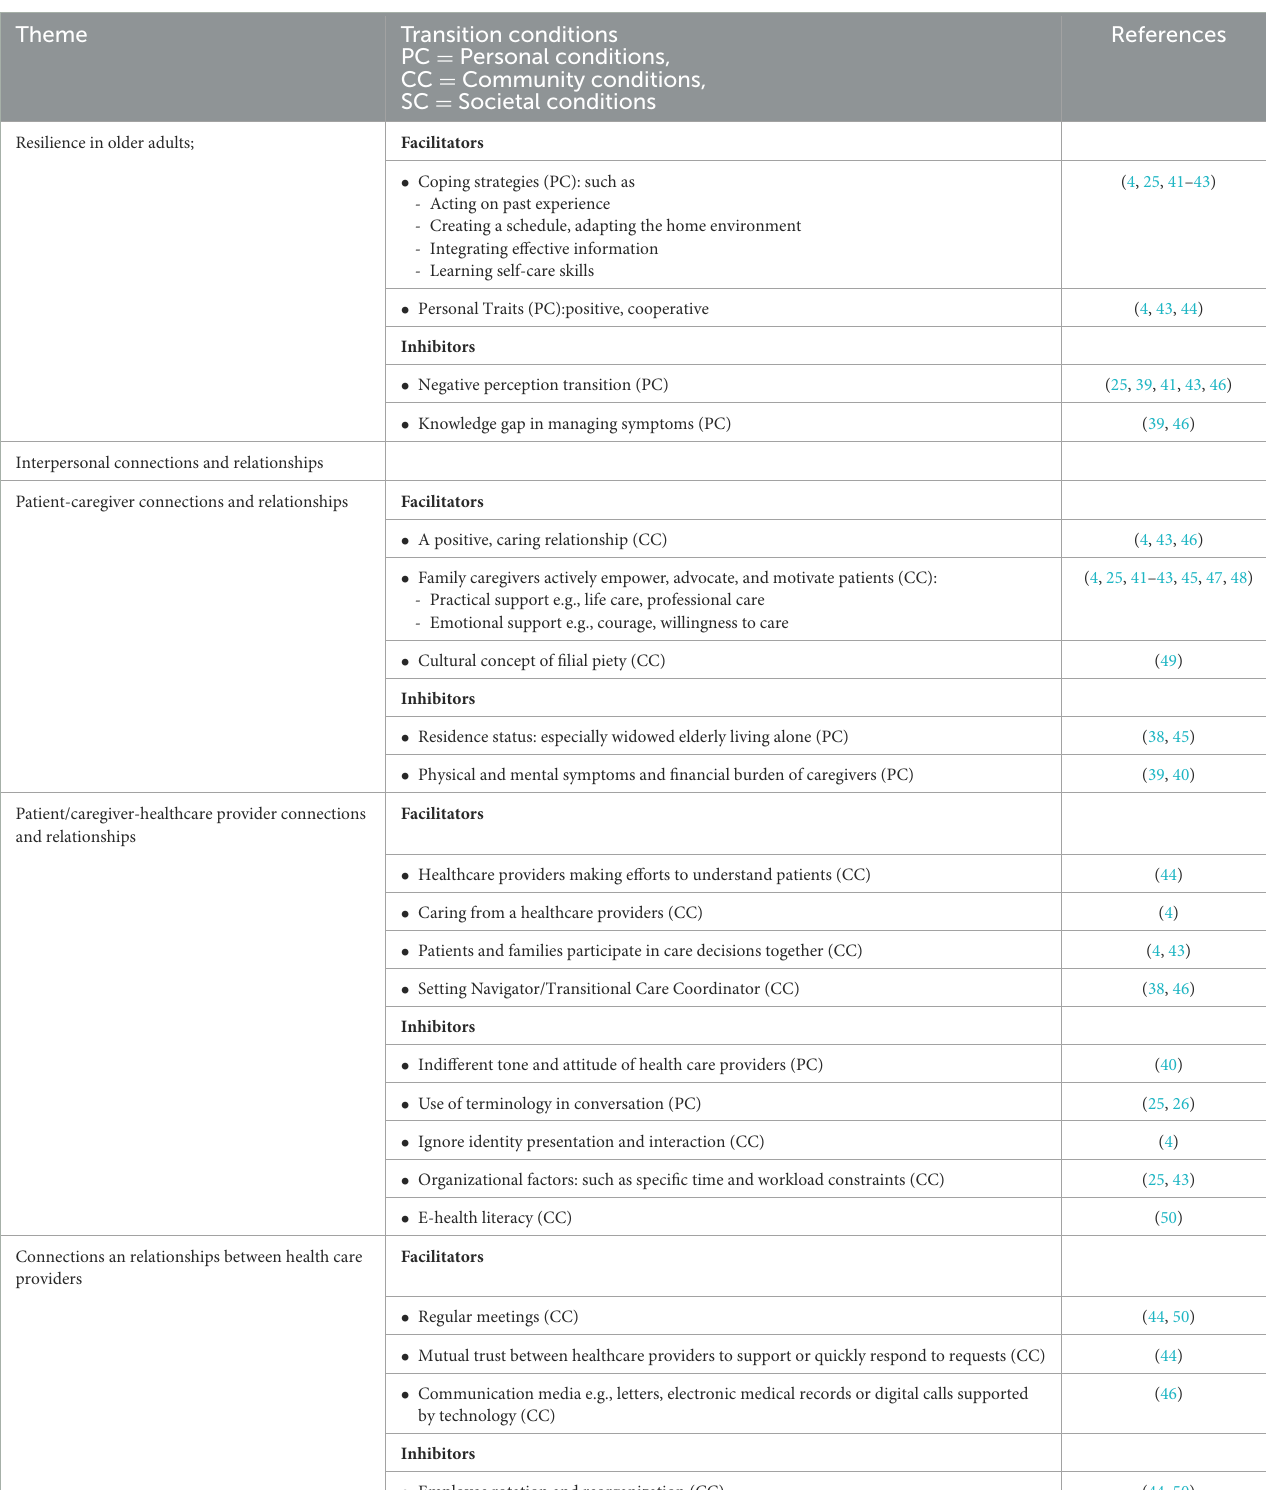
TABLE 3 Transition facilitators and inhibitors. Theme Transition conditions PC = Personal